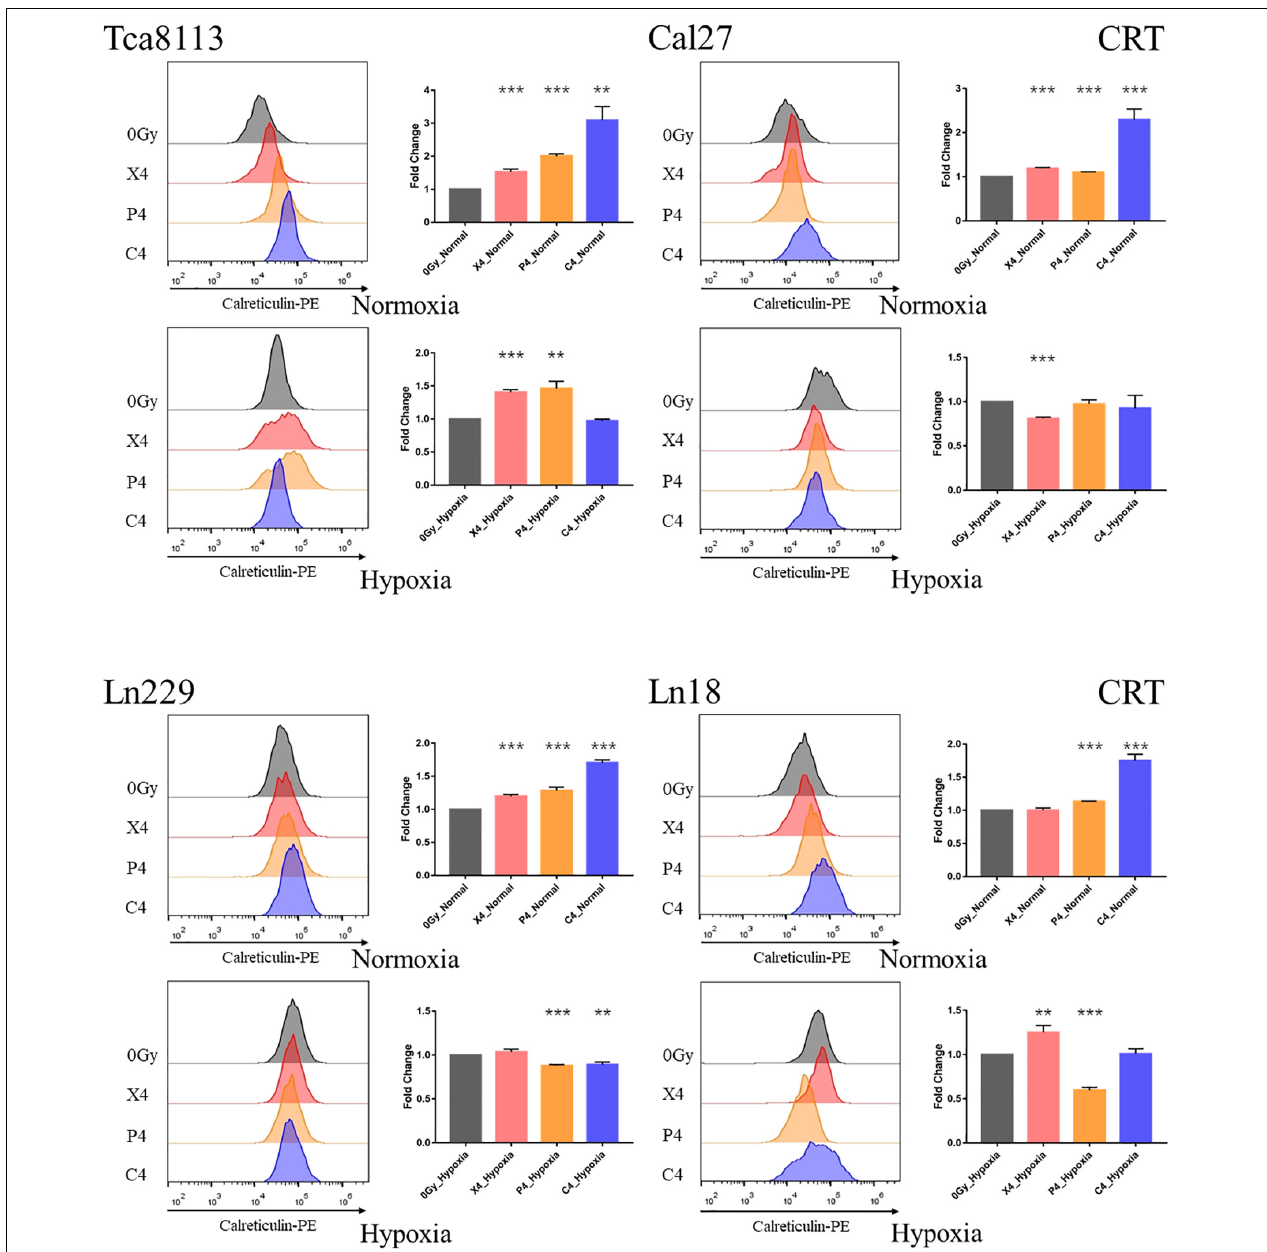
FIGURE 3 | Comparison of CRT expression under normoxia and hypoxia. Tumor cells were exposed to 4Gy physical dose photon, proton, or carbon-ion radiation. The expression level of CRT on the tumor cell surface was detected by flow cytometry 48 h after irradiation. Representative flow cytometry images for each group are shown in the half-offset histograms. The horizontal axis represents the fluorescence intensity of CRT-PE, and the vertical axis represents the number of cells. The fold change of the median fluorescence intensity (MFI) for each group relative to the control group (0Gy) is shown in the bar charts. Results are presented as mean ± s.d. Each experiment was repeated at least three times. Statistical significance of each irradiated group relative to the control group (0Gy) was indicated by asterisks. ** p < 0.01, and *** p < 0.001.